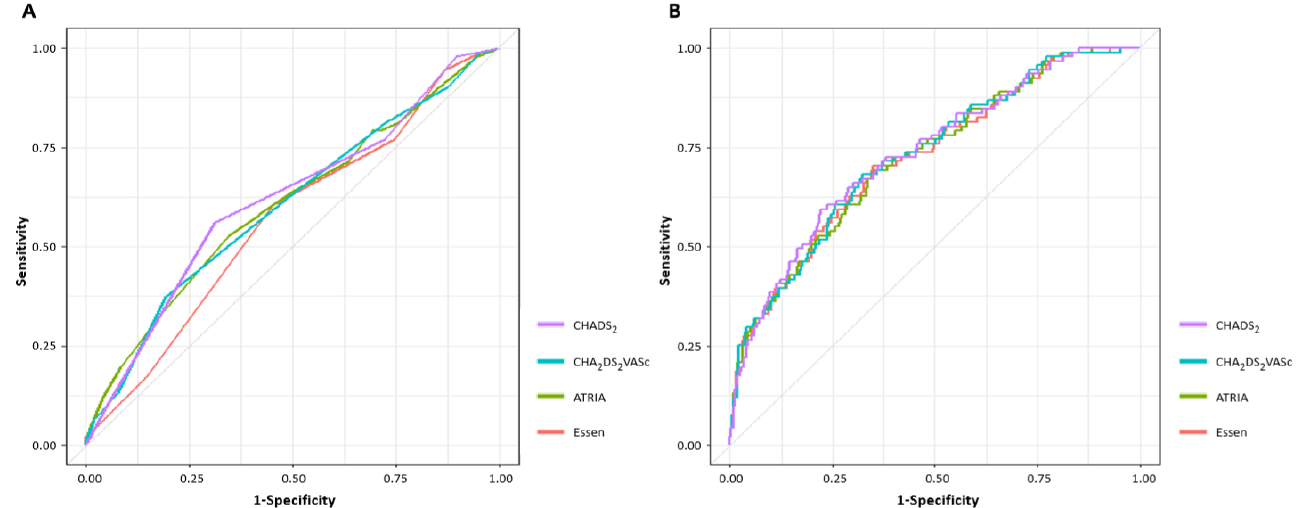
Figure 3. Receiver operating characteristic curve analyses of unsuccessful recanalization based on stroke risk scores. ( A ) Univariable ROC analysis ( B ) Multivariable ROC analysis. ROC, receiver operating characteristic.